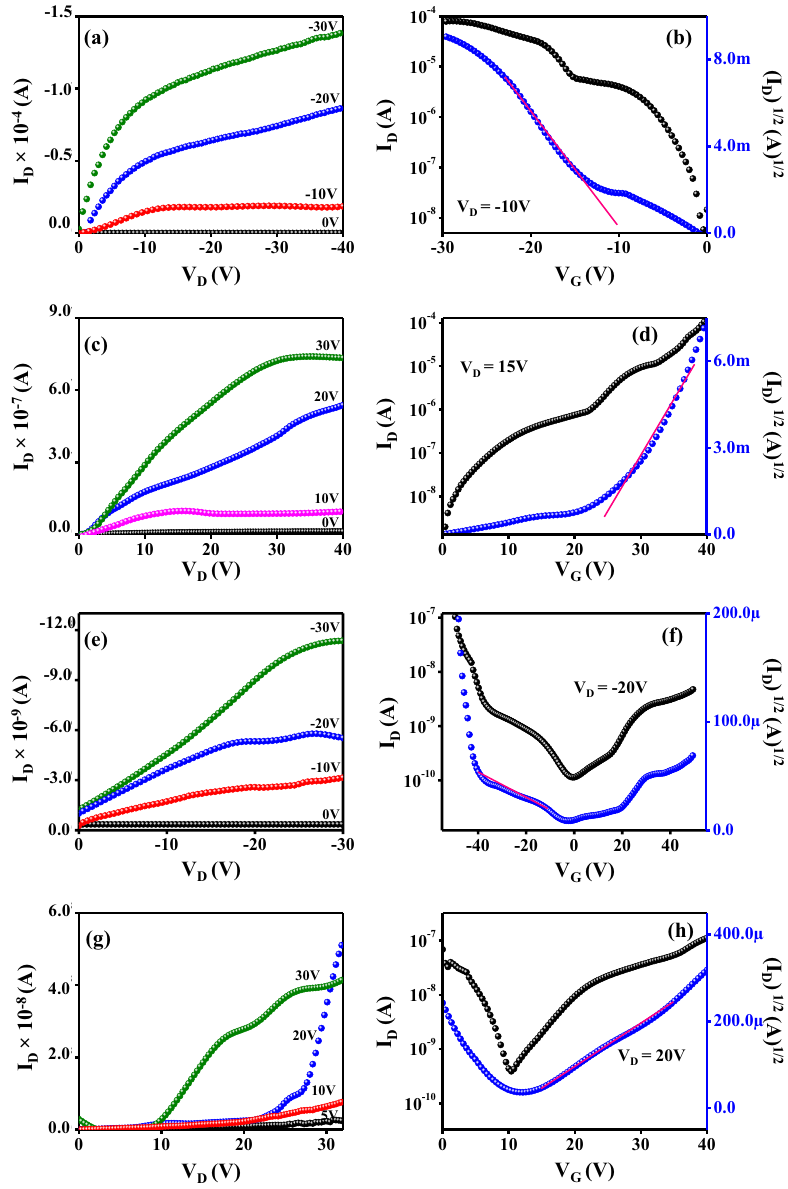
Figure 9. OFET characteristic curves of D ( a , b ); A ( c , d ); p- channel ( e , f ) and n-channel ( g , h ) of 1/1 blend. Graphs were plotted using Origin software (https ://www.origi nlab.com/, version: 8.5).